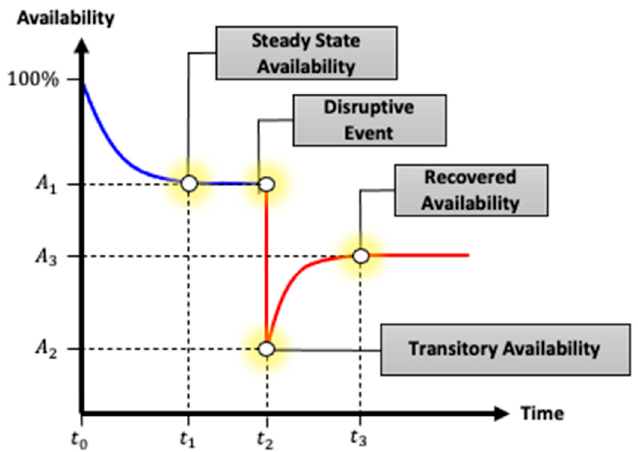
Figure 1. Representation of the availability behaviour affected by a disruptive event.